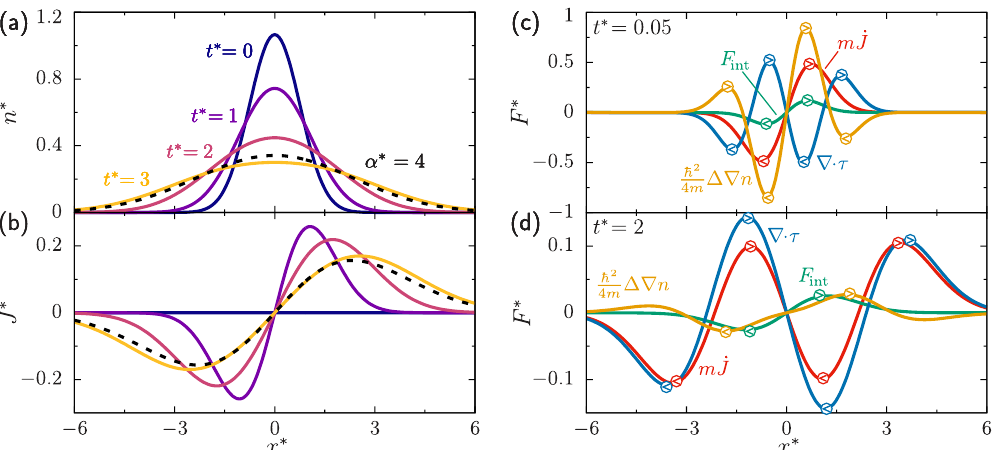
√ ¯ h / m ω and ( b ) the reduced current density √ m ω /¯ h for (cid:101) /¯ h ω = 0.5 and α ∗ = 1. √ ¯ h / m ω